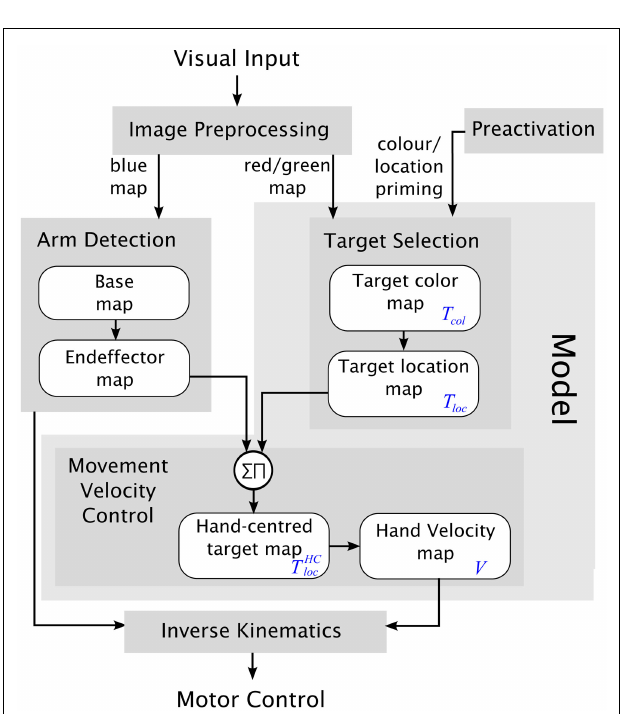
FIGURE 3 | Overview of the control architecture. The light gray box contains the model. Dark gray boxes are the modules of the model.White boxes symbolize DNFs. In the text the blue abbreviations are used for the respective